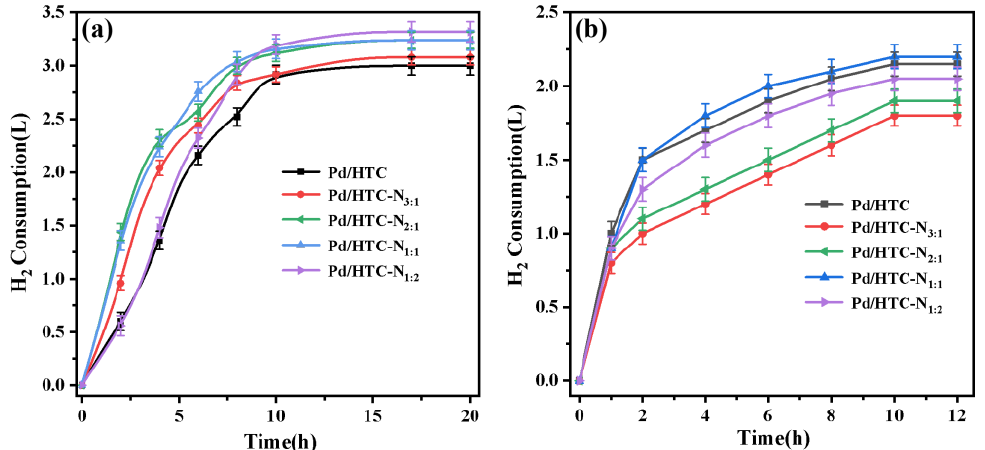
Figure 4. Hydrogen consumption amounts as functions of reaction times during the hydrogenolysis reaction of HBIW ( a ) and TADB ( b ) over various catalysts.